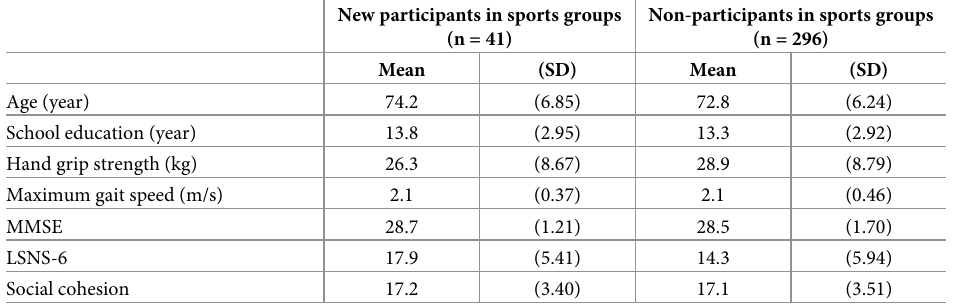
Table 1. Baseline characteristics of older adults according to the status of participation in sports groups at follow- up (continuous variables). New participants in sports groups (n =